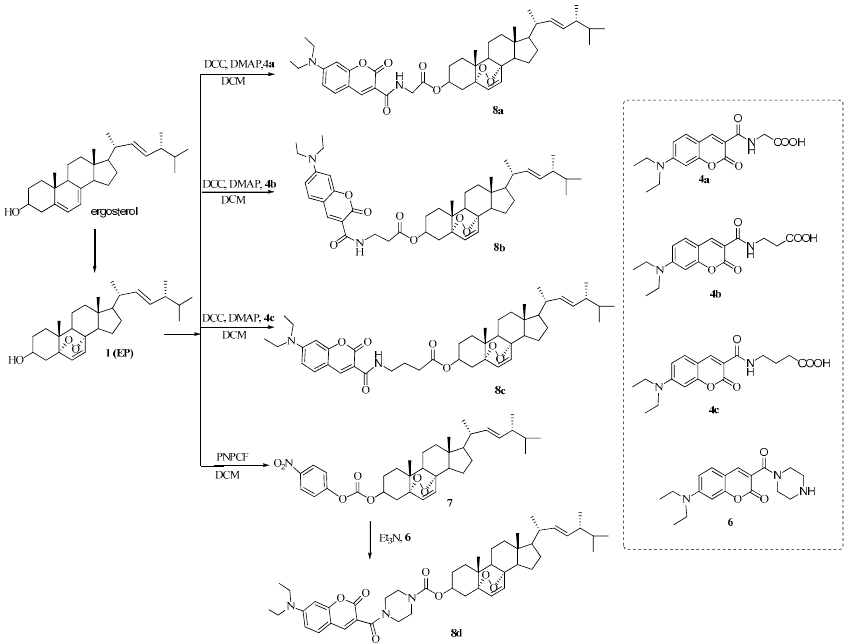
Table 1. Photophysical data for probes 8a – d and 2 [a] .